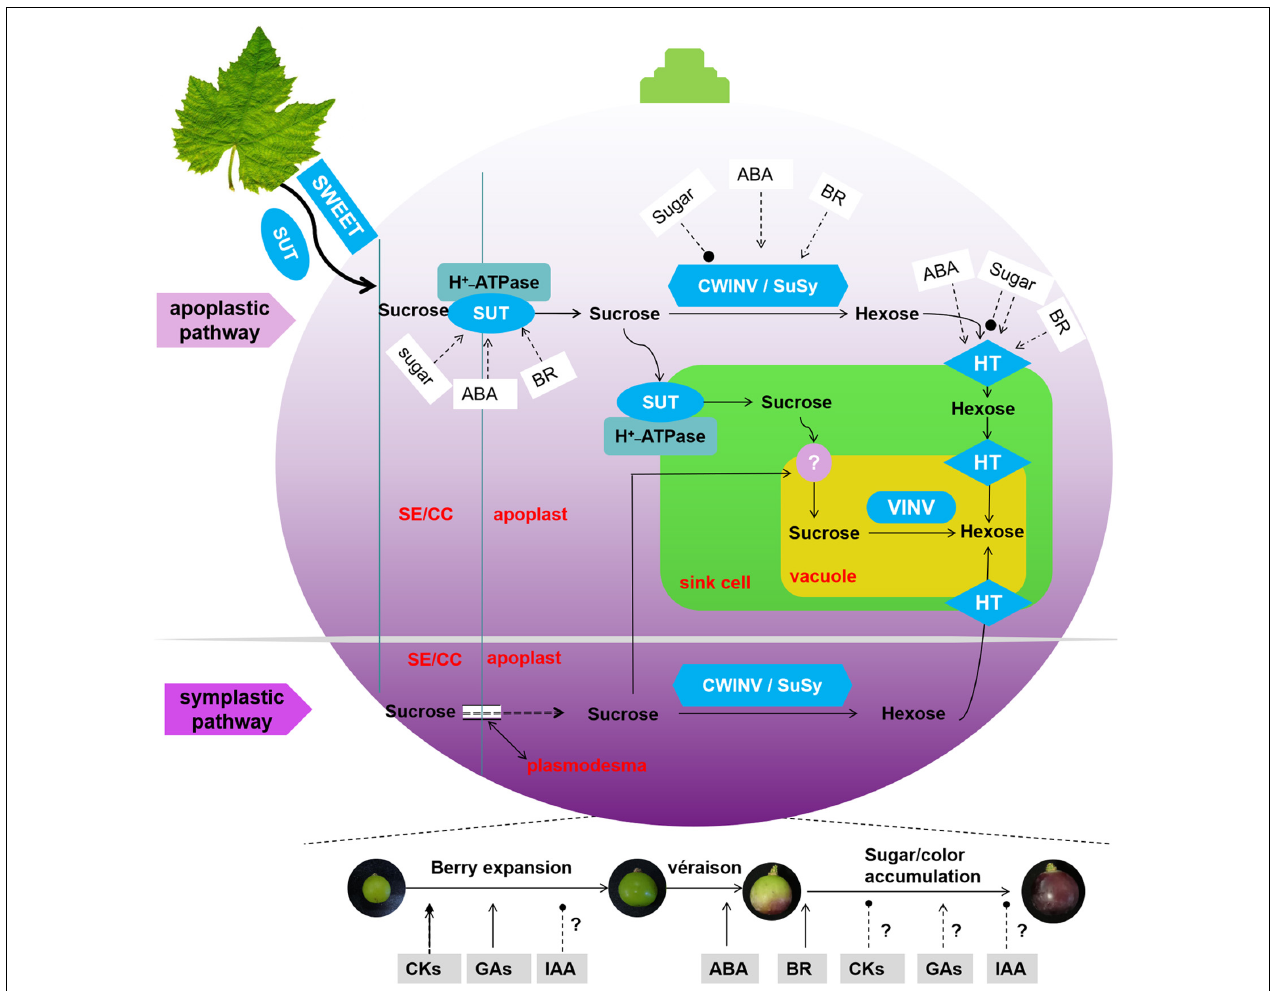
FIGURE 3 | Model of the molecular basis for the progress and regulation of sugar accumulation in grape berry. Symbol ‘?’ means no clear relationship between hormones and sink size (berry expansion) and sink activity (sugar accumulation), → in blue stands for promotion, — • in blue stands for